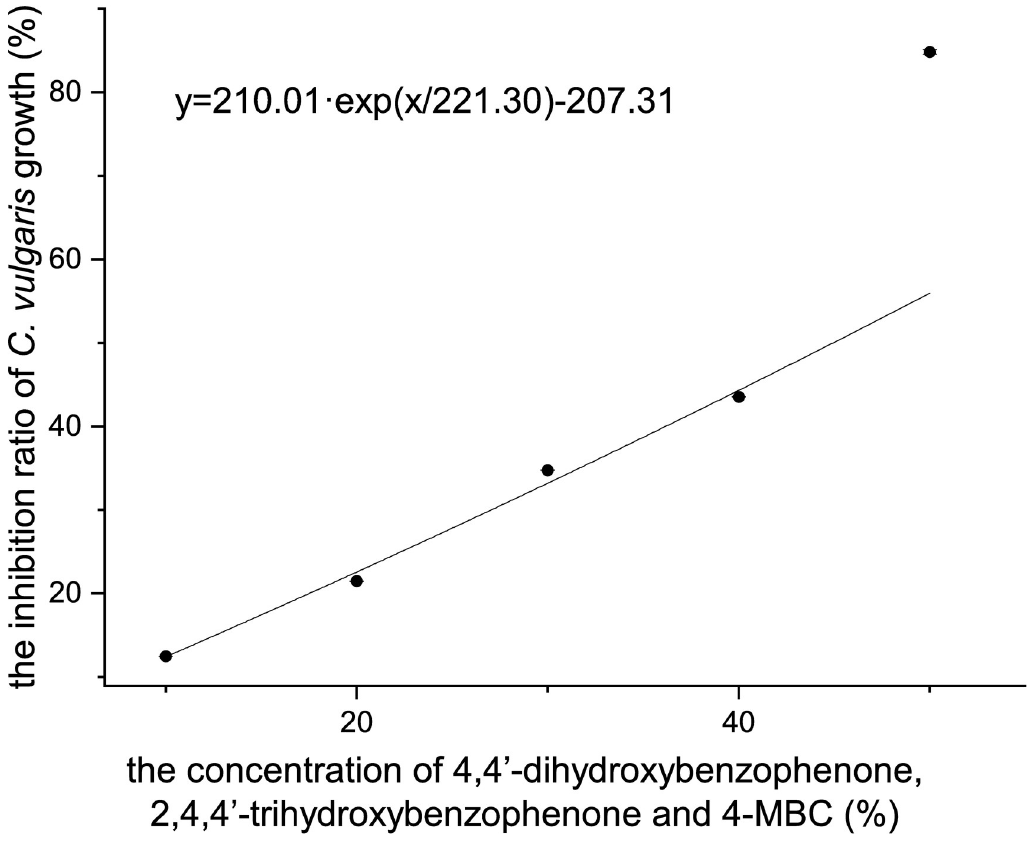
Fig 7. The inhibition ratio of C . vulgaris growth of a mixture of 4,4’-dihydroxybenzophenone, 2,4,4’- trihydroxybenzophenone and 4-MBC.